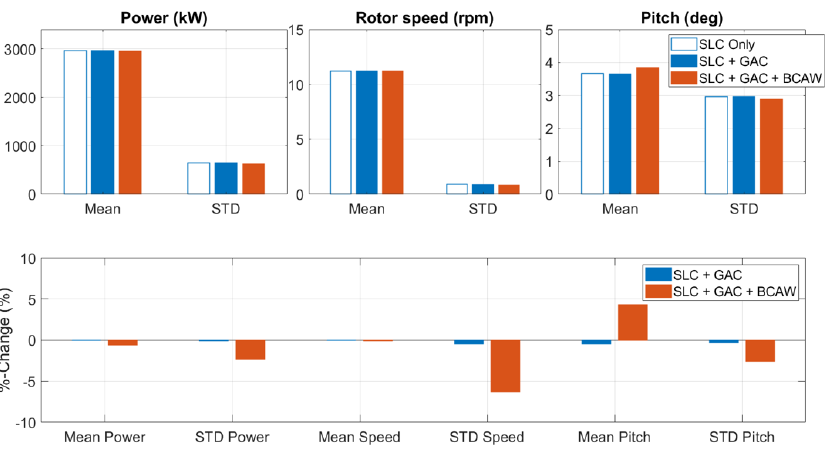
Figure 12. Variation of the mean and standard deviation of the power, rotor speed and pitch angle under normal turbulence wind with different control architectures. Top—Dimensional values; Bottom—Percentage changes with respect to the ‘SLC Only’ case.